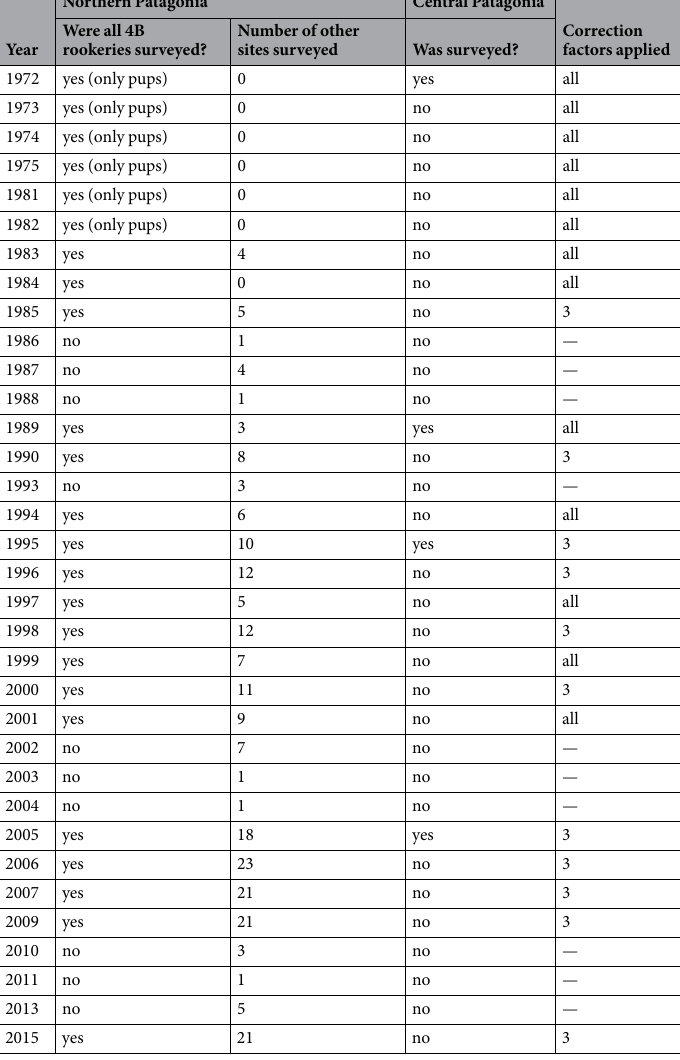
Table 3. Synoptic view of the available survey data of South American sea lion Otaria flavescens from northern and central Patagonia. 4B are Punta Norte, Punta Buenos Aires, Punta Pirámide, and Punta León